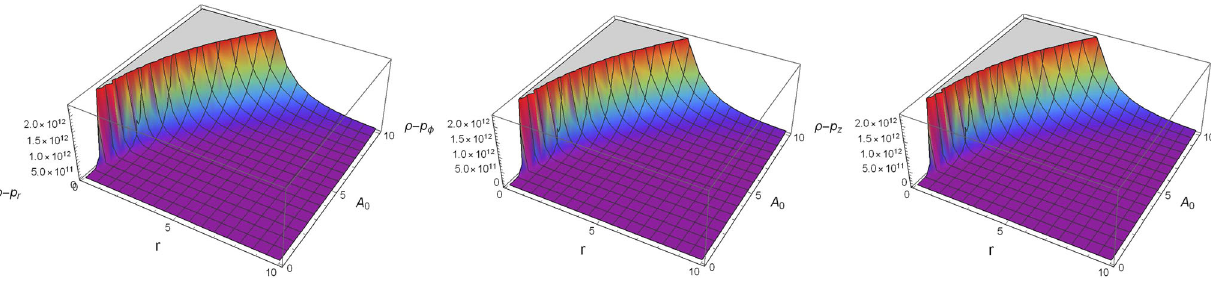
Fig. 32 These graphs shows the behavior of (ρ − p r ) (MeV/fm 3 ) , (ρ − p φ ) (MeV/fm 3 ) and (ρ − p z ) (MeV/fm 3 ) w.r.t r (km) with m = − 3,